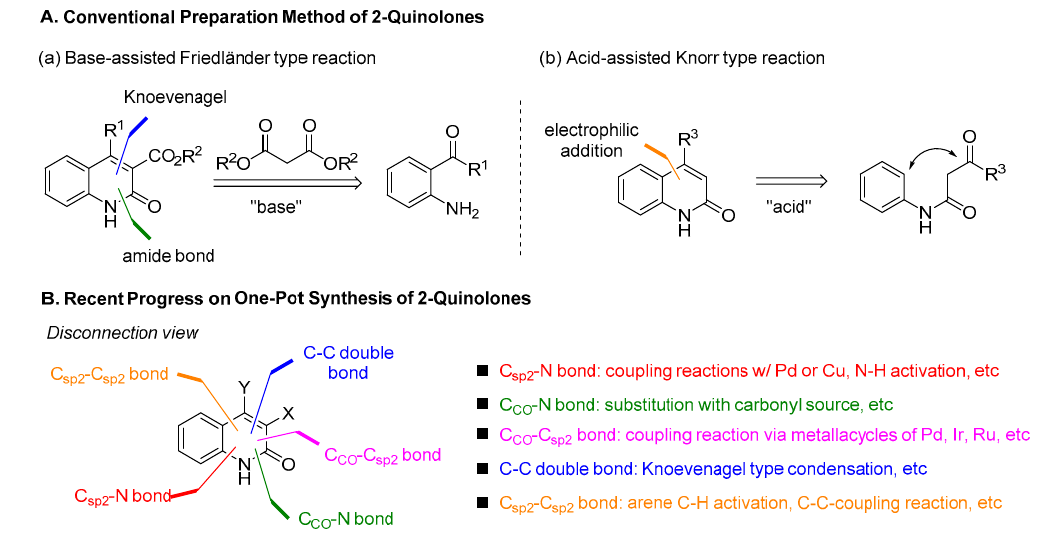
Figure 3. Overview of classical and recent approaches to 2-quinolones.